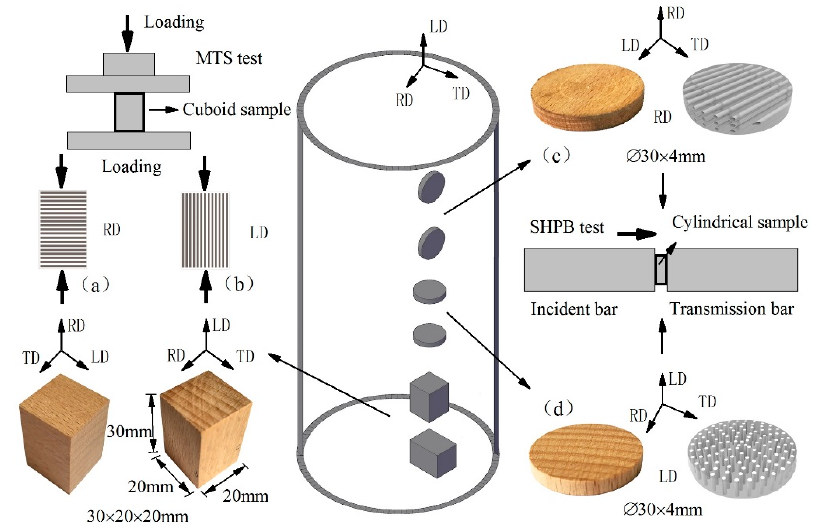
Figure 1. Real specimen pictures and a schematic diagram of test specimens for ( a ) the Material Testing Simulation (MTS) test in the radial direction (RD), ( b ) MTS test in the longitudinal direction (LD), ( c ) split Hopkinson pressure bar (SHPB) test in the RD, and ( d ) SHPB test in the LD.